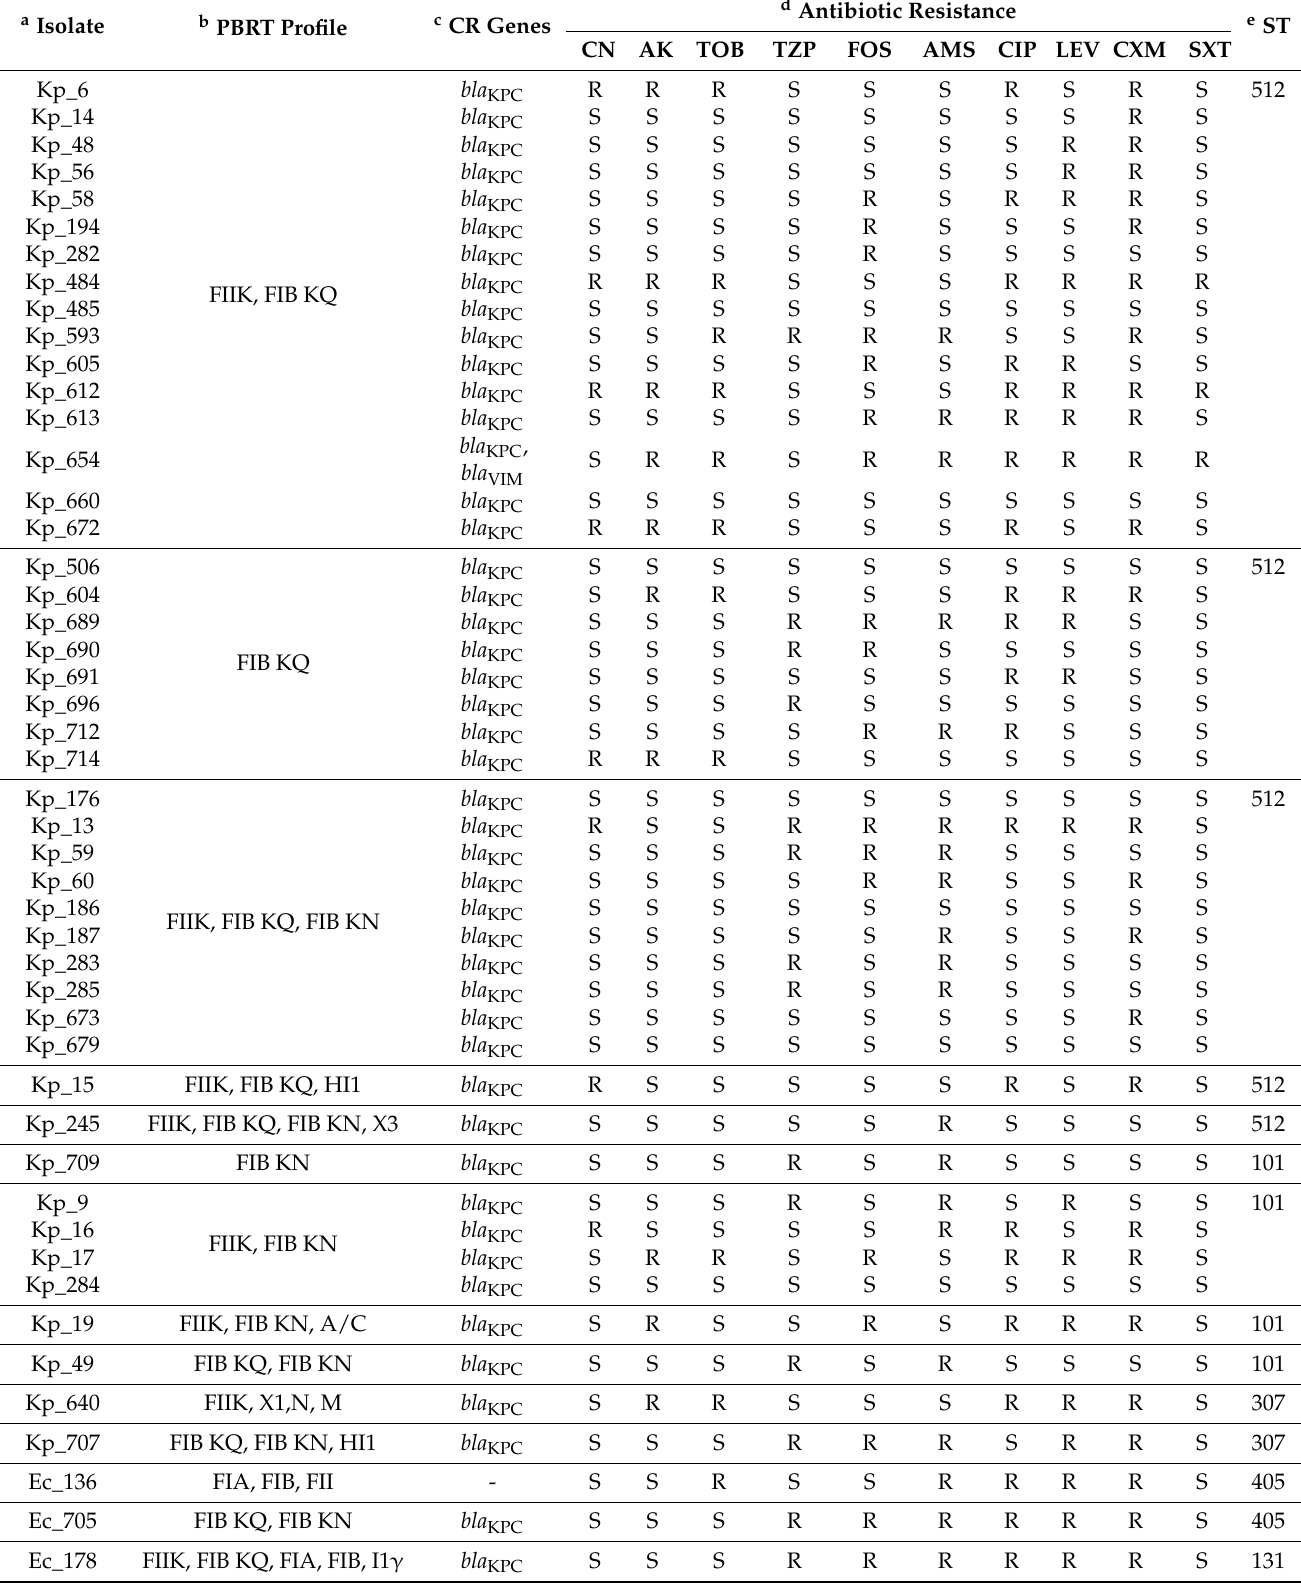
Table 1. Genotypic and phenotypic profiles of strains isolated from rectal